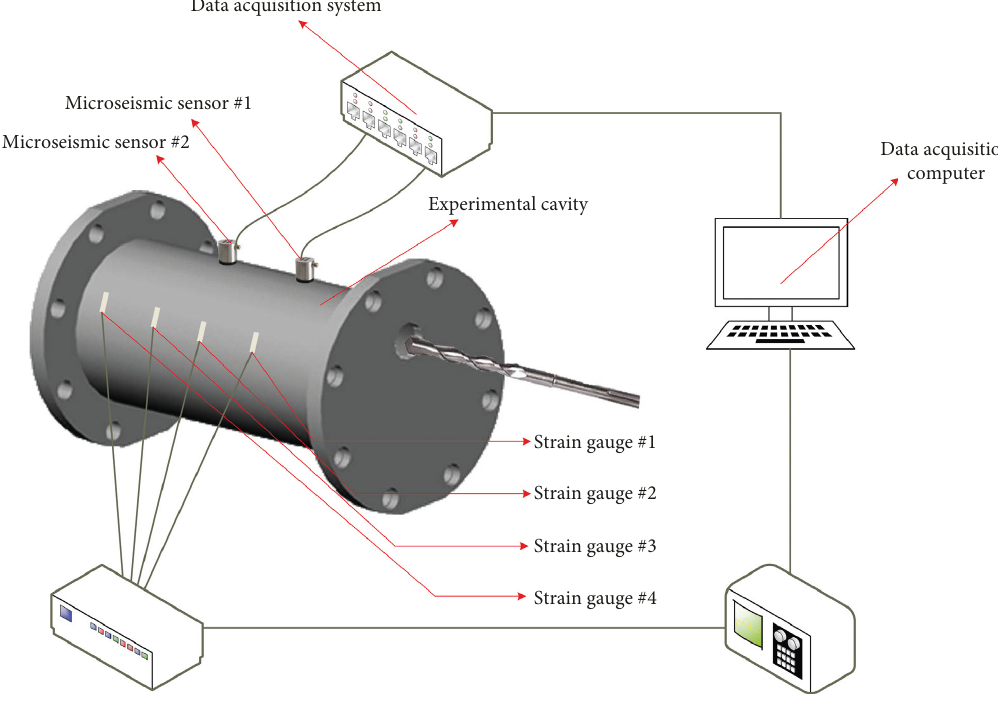
Figure 1: Experimental system.